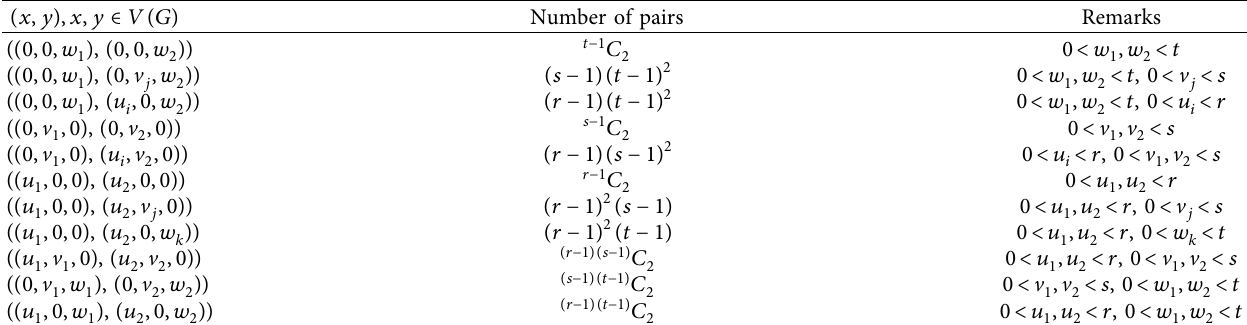
Table 17: Information related to the pair of nodes of G having distance 2.